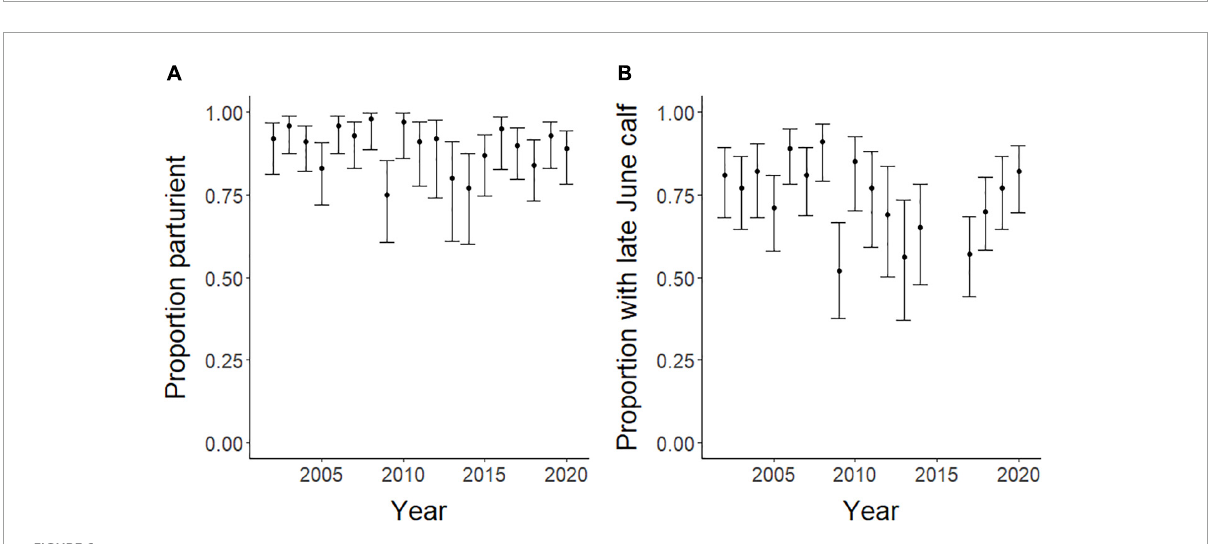
FIGURE6 Annual population-level proportion of female caribou that were parturient or had a calf at heel in late June (and 95% confidence intervals) in the Central Arctic Herd, Alaska,